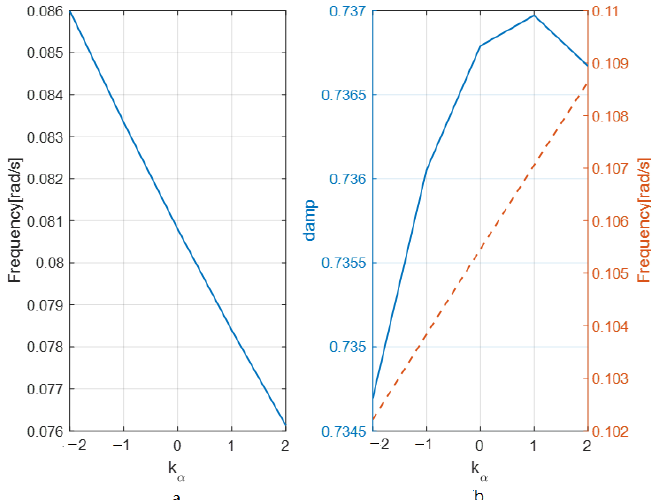
Figure 4. Curve of Influence of Moment of Aerodynamic Stabilization on Pitching Channel Motion Mode: (a) frequency change curves of the fi rst-order inertial damping mode under the perturbation of the pitch aerodynamic stability moment (b) damping and frequency change curves of the second-order oscillation convergence mode under the perturbation of the pitch aerodynamic stability moment.